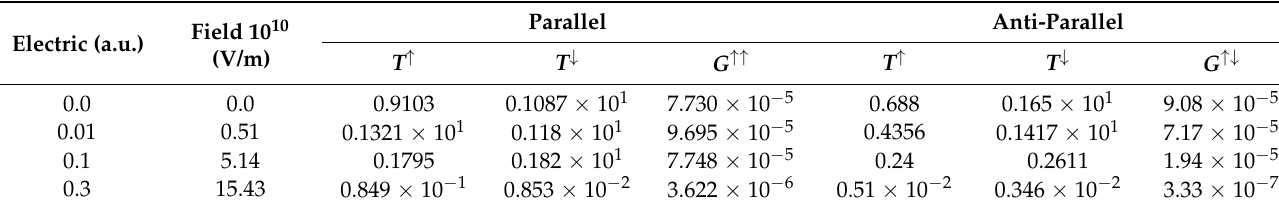
Table 4. Effect of electric field on spin conductance of Co(111)/MoS 2 /Co(111) stack. Electric